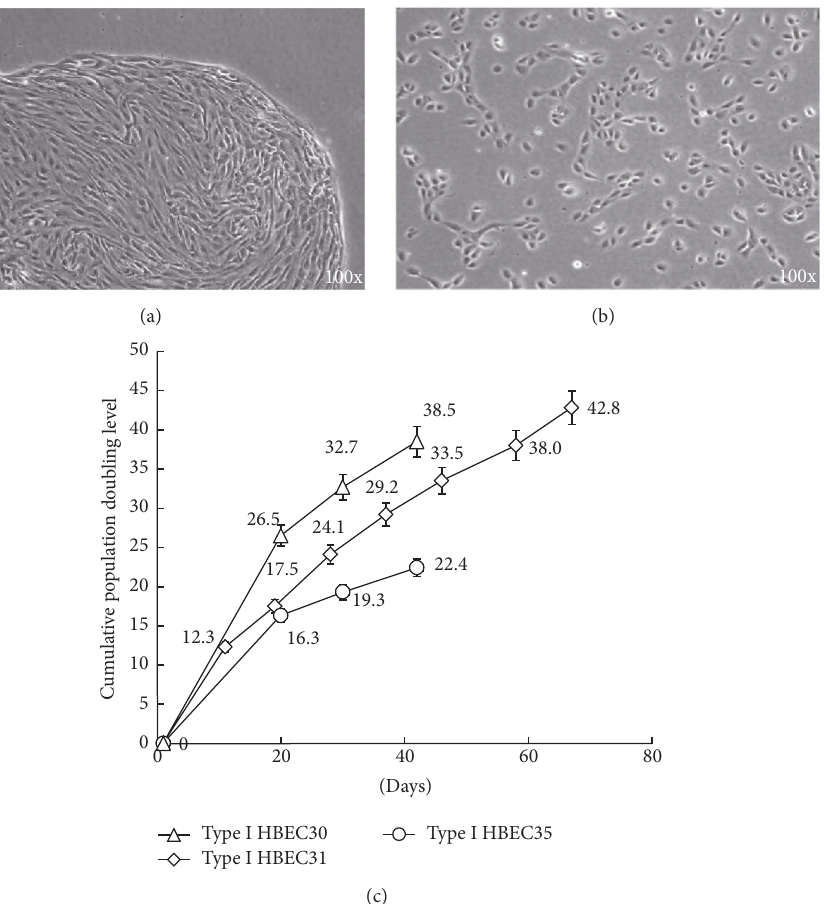
Figure 1: Type I HBECs plated and cultured in MSU-1 medium (a) formed colonies with smooth and restricted boundaries, the cells in colonies were contiguous and variable-shaped, and Type I HBECs grown in K-NAC medium (b) were dispersed. (c) Proliferation potential of Type I HBECs cultured in K-NAC medium: cpdl = 38.5, 42.8, and 22.4, respectively, for HBEC30, HBEC31, and